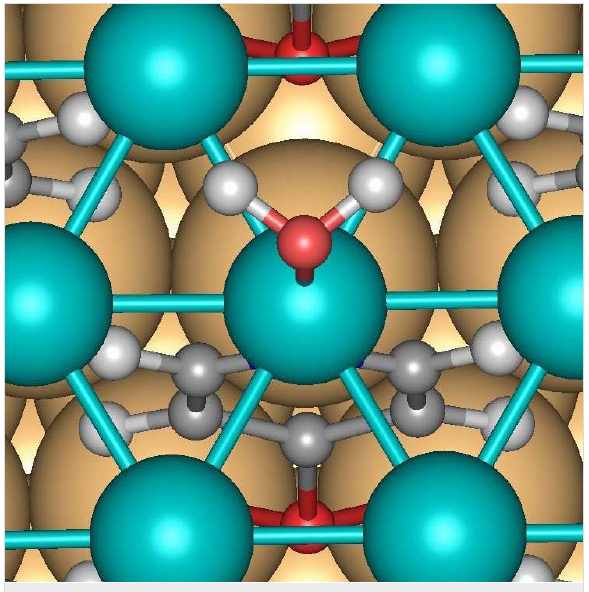
Figure 1: Top view of the optimized structure of a single H 2 O mole- cule on the palladium monolayer of the ( )R30° Au/Mpy/Pd